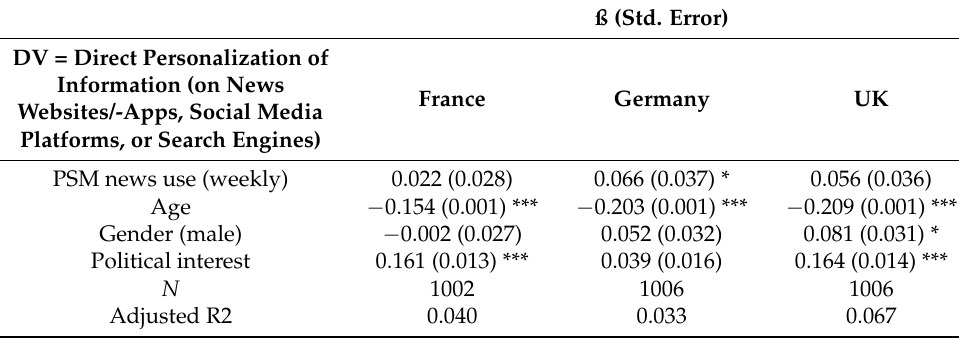
Table 5. Linear regression analysis of predictors for direct personalization.